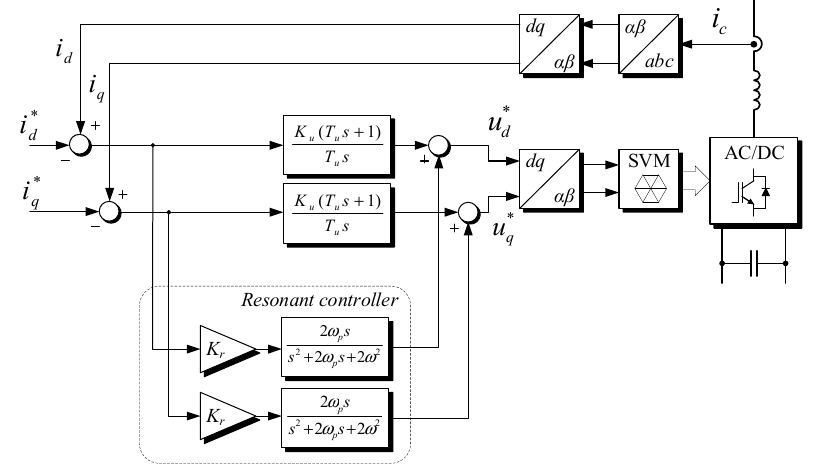
Figure 6. Current controller with resonant path (* denotes reference values).